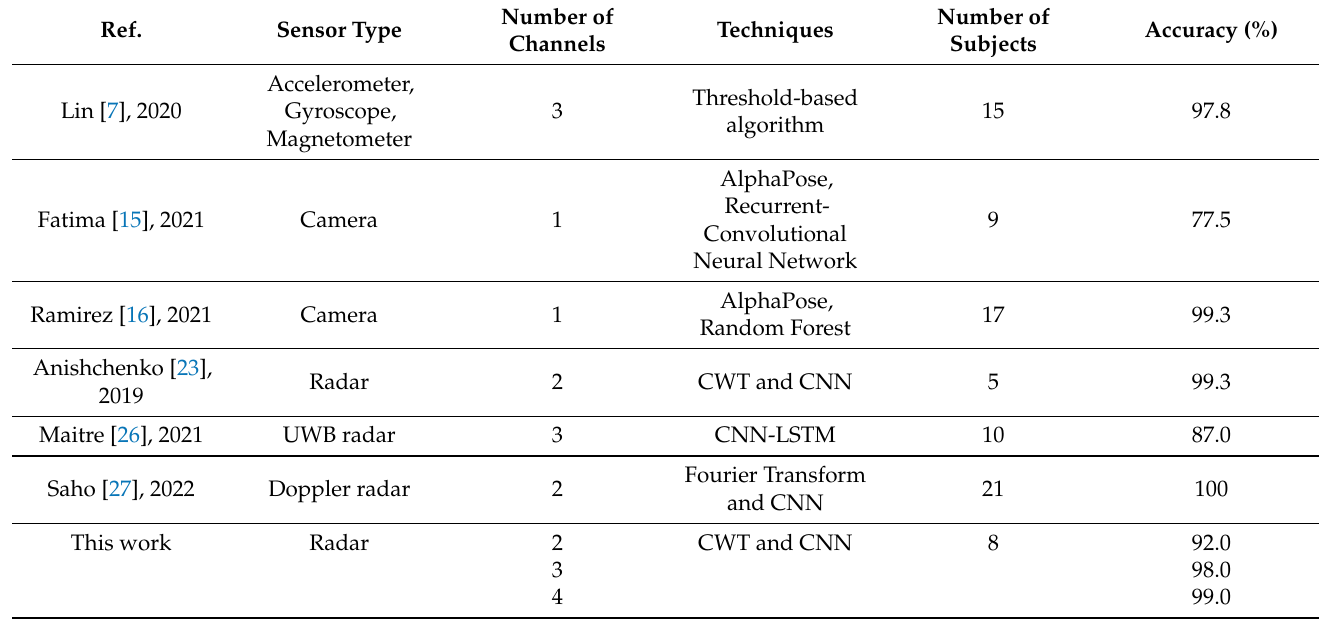
Table 4. Comparison between the achieved results and other